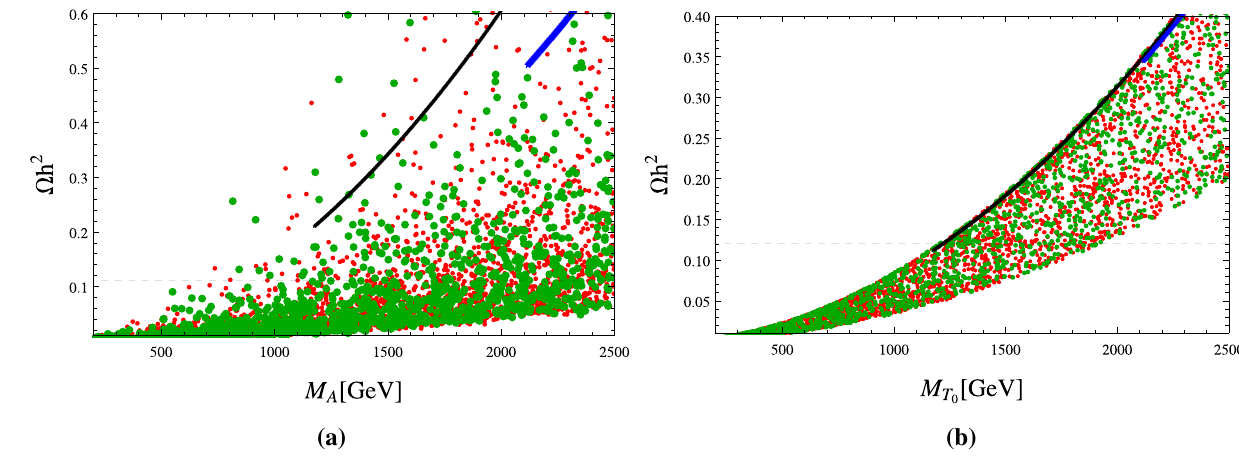
Fig. 17 Relic density verses dark matter mass in GeV: a inert Higgs doublet model; b inert Higgs Triplet Model. Red colour correspond to theelectroweaksymmetrybreakingallowedpoints,Greencolourcorre-